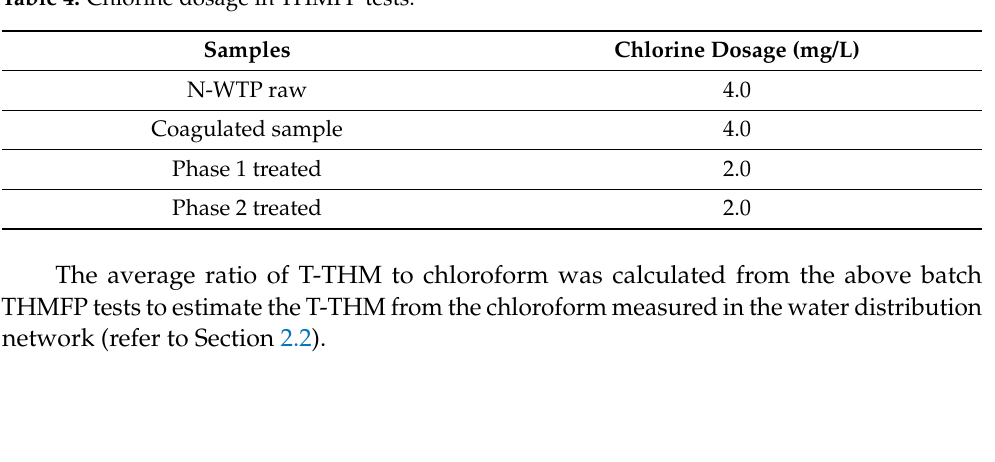
Table 4. Chlorine dosage in THMFP